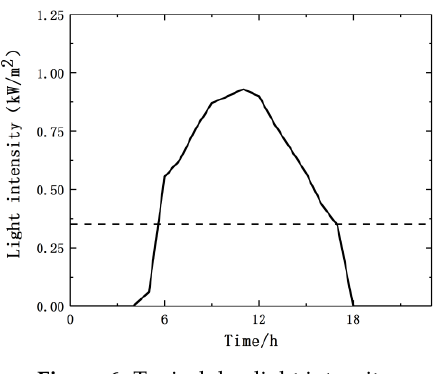
Figure 6. Typical day light intensity. Table 1. Wind turbine, PV, and pumped storage unit cost and reliability parameters.